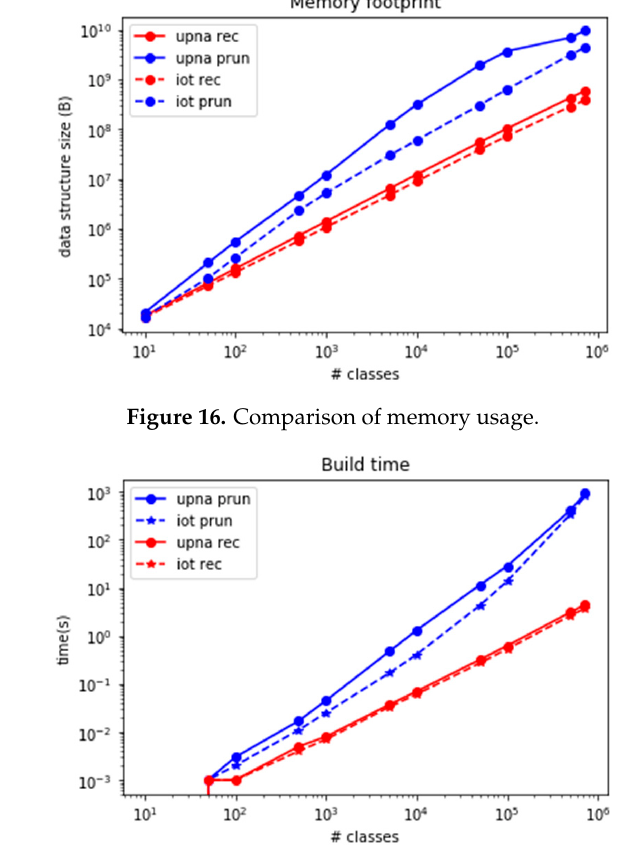
Figure 17. Comparison of required time to add a new class.